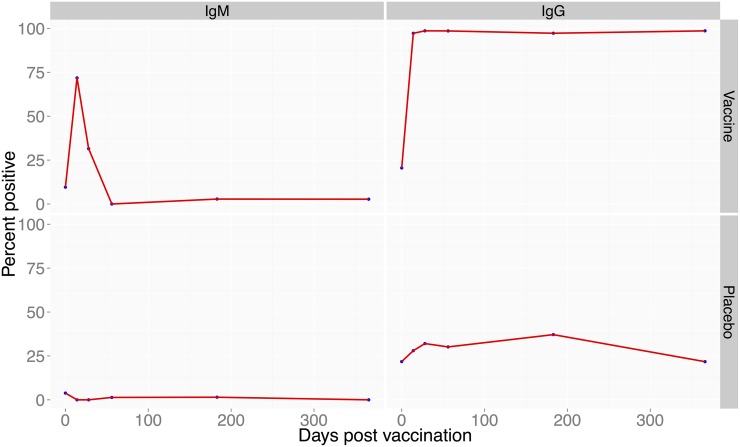
Proportion of goats positive for anti-RVF antibodies following vaccination with RVF Clone 13 vaccine.Left panel (bottom) proportion of the goats with IgG antibodies following vaccination within 14 to 366 days post-vaccination. The right panel (bottom) shows proportion of goats that produced anti-RVF IgM antibodies over the 1 year period. The top panel on the left and right are the placebo-treated animals.